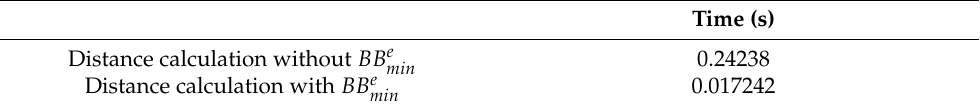
Figure 14. The representation of the test environment including the occupancy map, cylinder, and bounding box. Table 2. The results of tests for Algorithm 1 with and without bounding box.